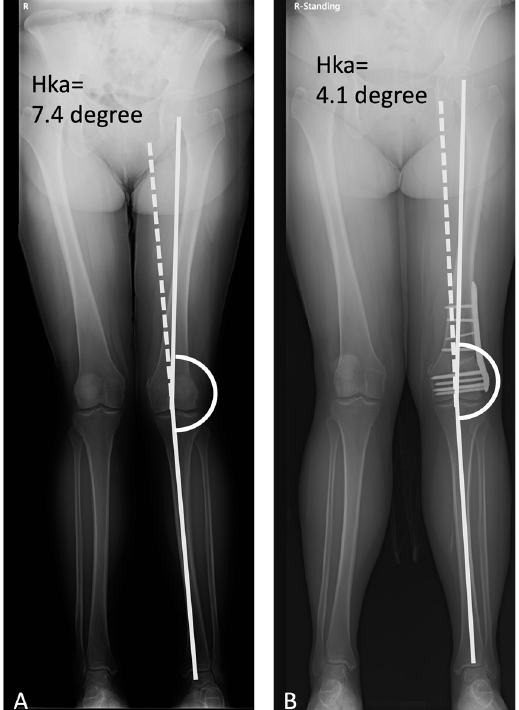
Figure 5. ( A ) Preop, Hka = 7.4 degree and ( B ) postop, Hka = 4.1 degree, split